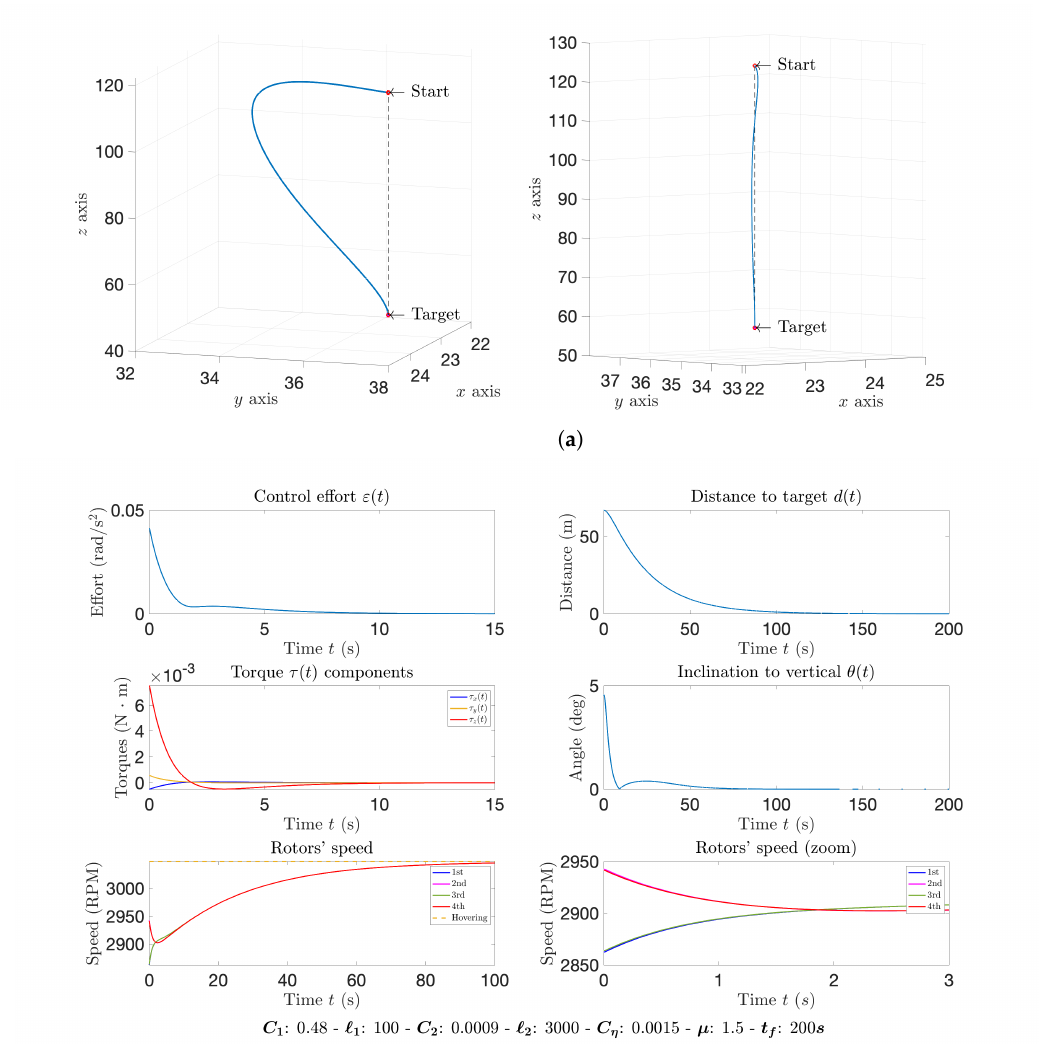
Figure 9. Experiment: Vertical ascension, random initial conditions. ( a ) Target approaching trajectory; ( b ) Control